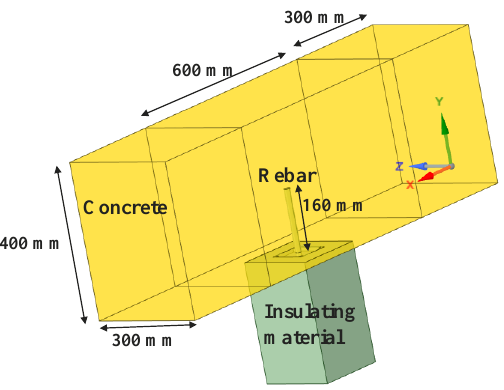
Figure 4. Geometry of the 3D modelling in Ansys.